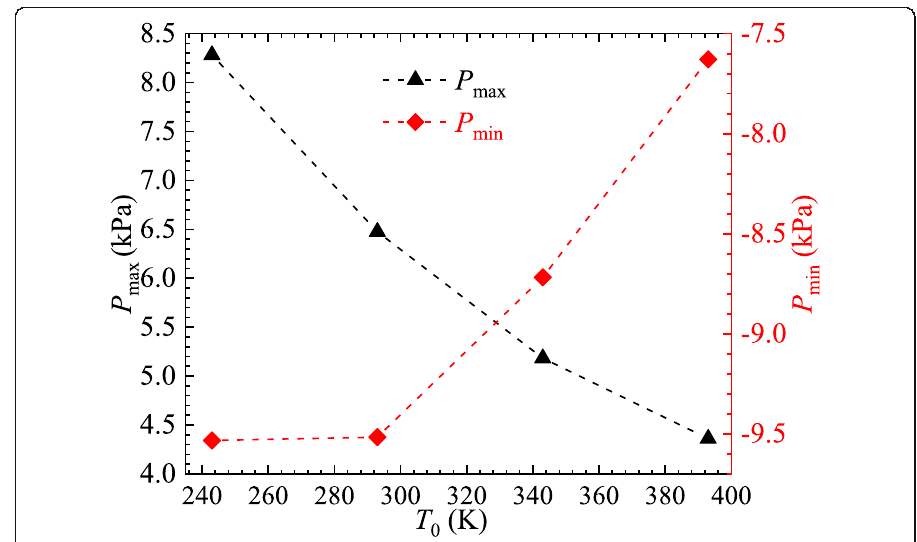
Fig. 14 Maximum and minimum pressure on the train surface at different T 0